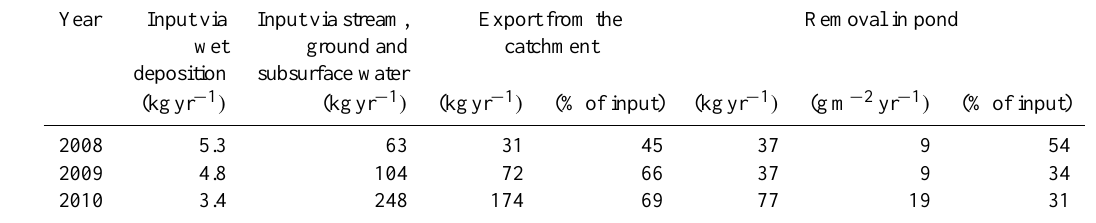
Table 4. DOC flux estimates into and out of the pond in the Chicken Creek Catchment between 2008 and 2010. Aerial estimates were based on a pond surface area of 4000m 2 .